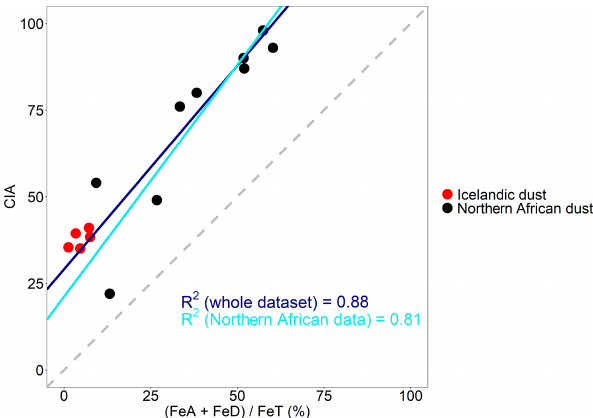
Figure 7. Correlation of the chemical index of alteration (CIA) with ( FeA + FeD )/ FeT (%) performed using the standard major axis re- gression. Data for African dust are from Shi et al. (2011b). The re- gression line in blue was calculated including the whole dataset: Icelandic dust (this study) and northern African dust (Shi et al., 2011b). The regression line in light blue was calculated using only the northern African dust data (Shi et al.,